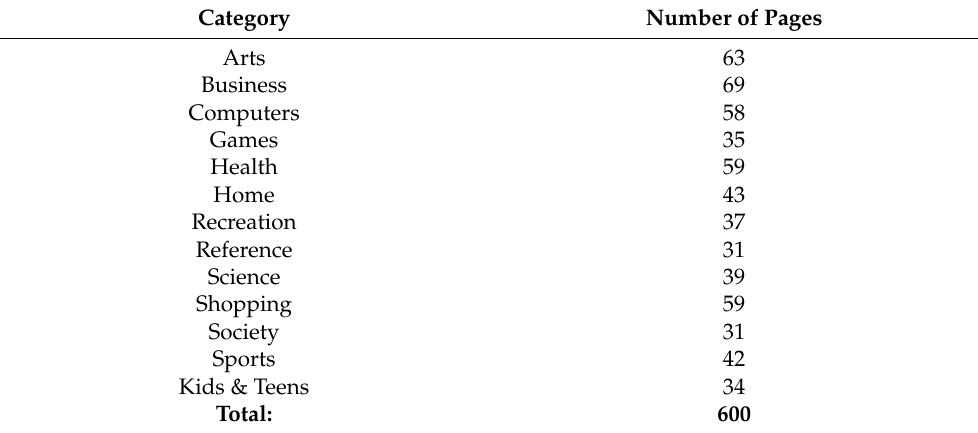
Table 1. Number of web pages in the sample by DMOZ categories.